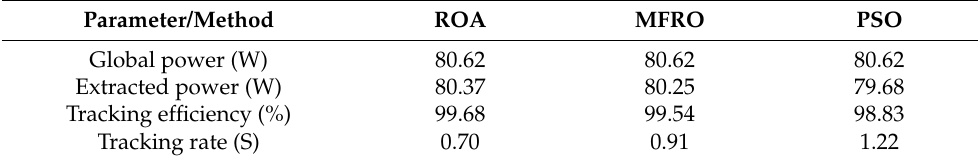
Figure 14. Characteristics of the PV panel for pattern 4: ( a ) P-V, ( b ) I-V. Table 7. Numerical results of the ROA, MRFO, and PSO methods in pattern